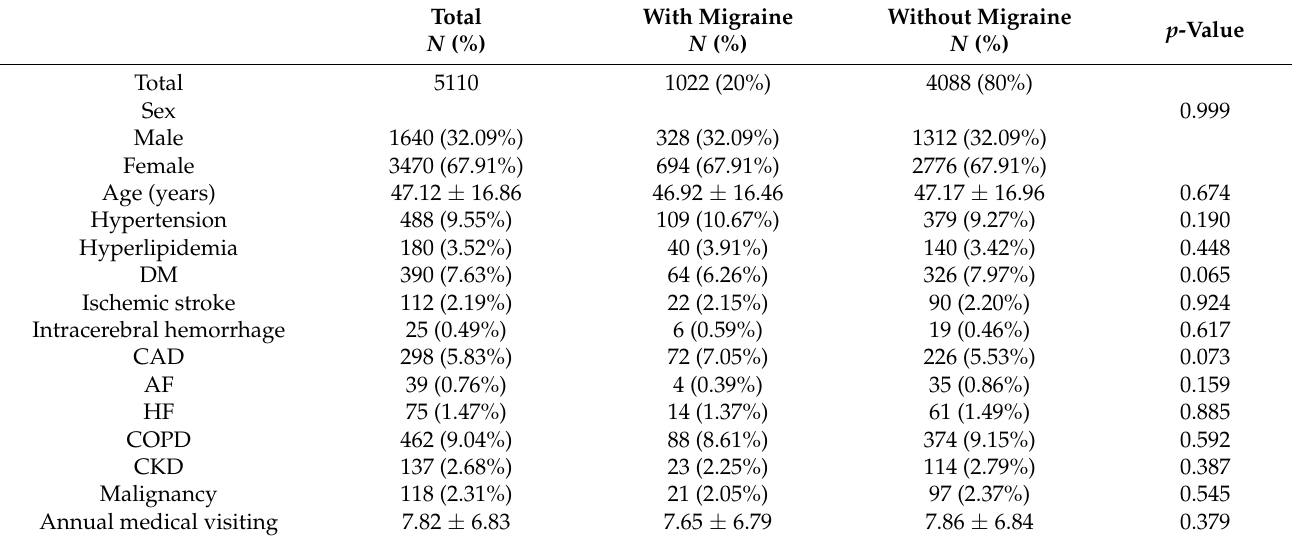
Table 1. Characteristics of the study participants at